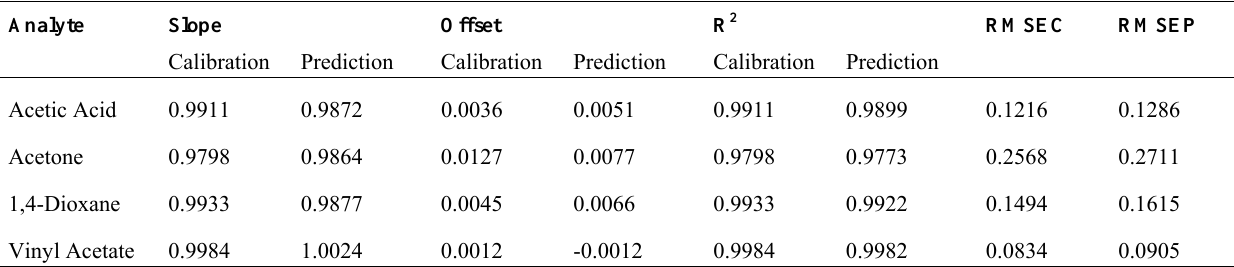
Table 3. Regression diagnostics for the PLS2 model based on four